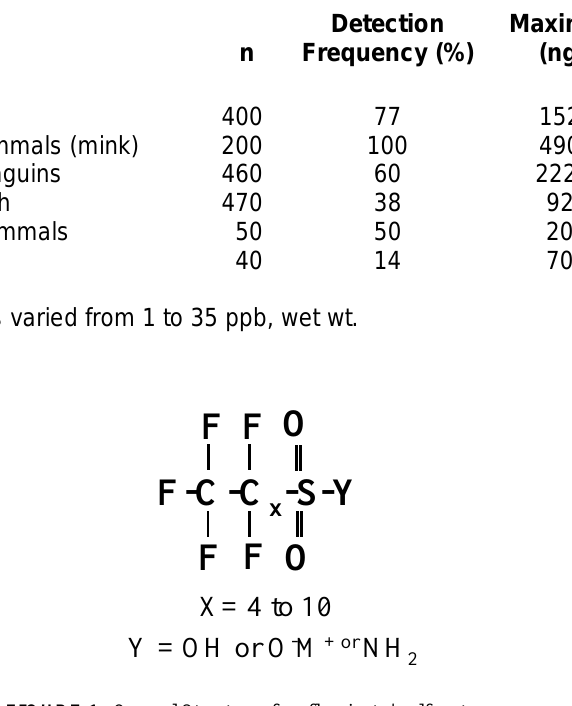
FIGURE 1. General Structure of perfluorinated